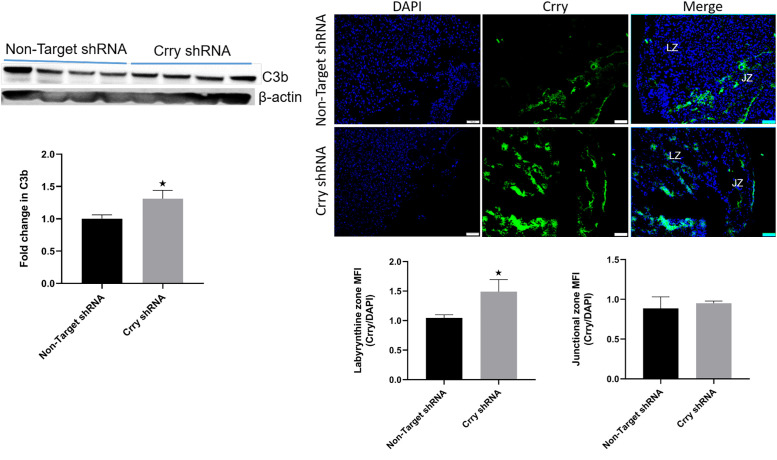
Crry downregulation triggered complement deposition on placenta.Placental complement deposition on 17.5 dpc was measured after shRNA induction on 10.5 dpc in pregnant mice (n = 5–7). Left panel is representative Western blot showing placental C3b deposition levels and density analysis of placental C3b Western blots showing significantly (p = 0.03) higher deposition in CrryshRNA mice compared to control group. Right panel is representative immunofluorescence images showing increased C3b deposition in CrryshRNA mice and semi-quantitation of fluorescence intensity showing significantly higher C3b deposition (p = 0.04) in the labyrinthine zone of CrryshRNA mice compared to control mice. There was no change in fluorescence intensity in junctional zone between the two groups.